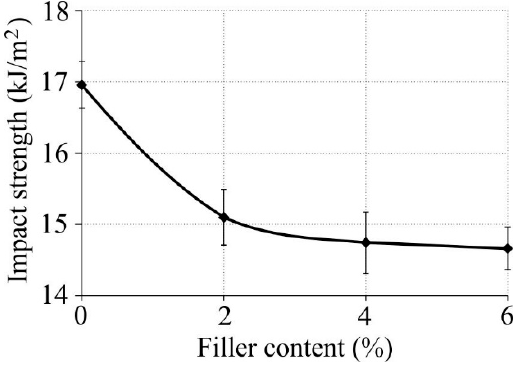
Figure 6. Impact strength of produced nanocomposites versus nanofiller mass content.